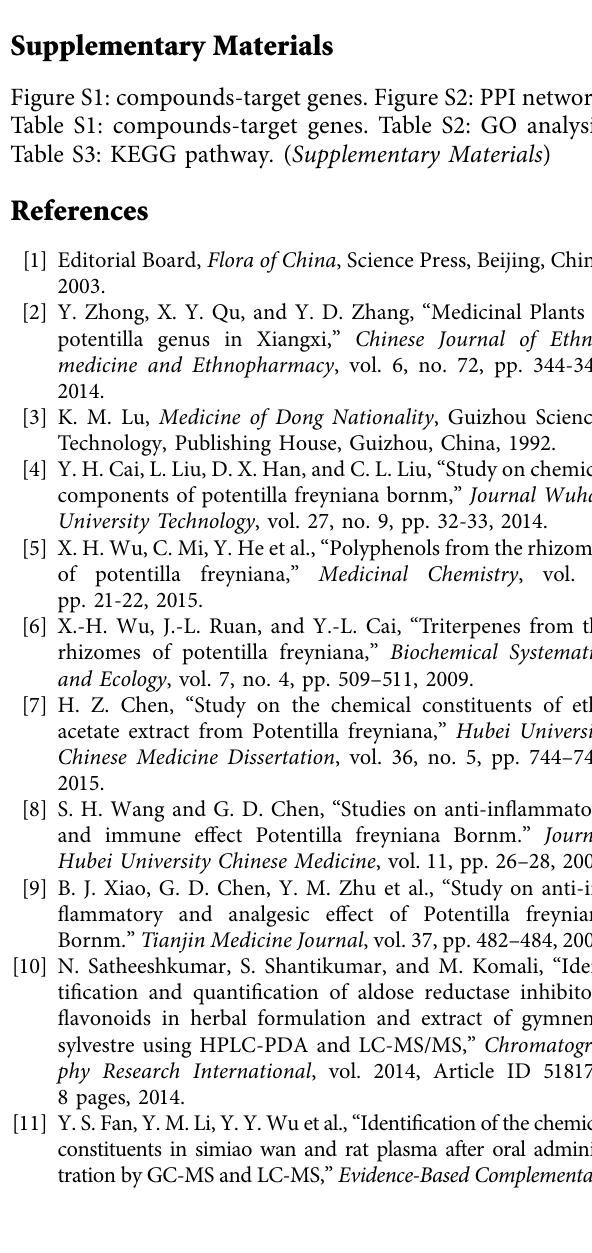
Figure 5: Chemical-target genes-pathway network: red represents chemical; blue represents target genes; green represents